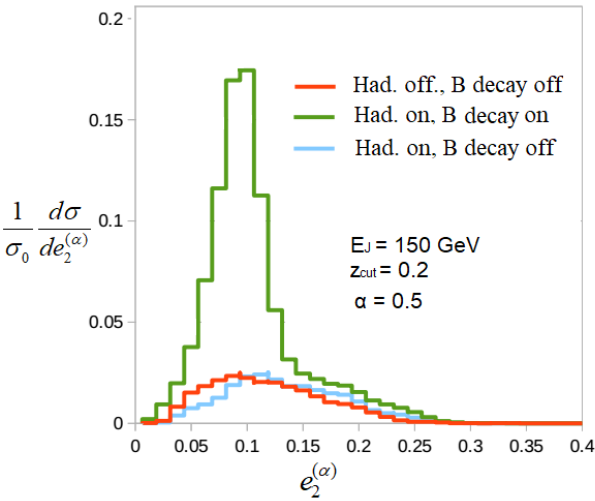
Figure 15 . E(cid:11)ect of B hadron decay is to produce a dramatic increase in the number of events contributing to the e ( (cid:11) ) 2